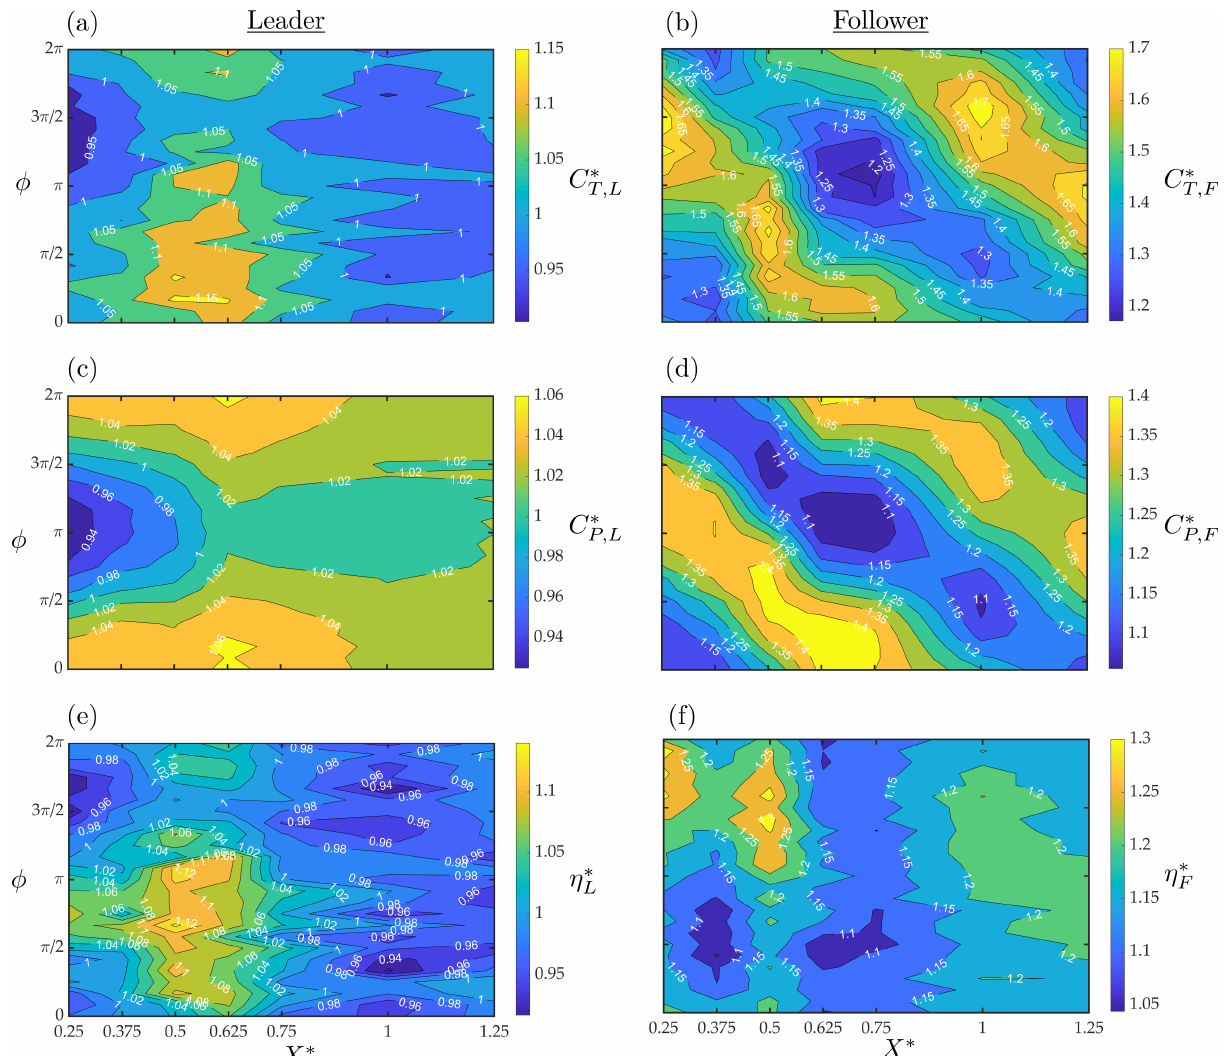
Figure A2. Normalized ( a , b ) thrust, ( c , d ) power and ( e , f ) efficiency of leader (left column) and follower (right column) in in-line arrangements as a function of synchrony and streamwise foil